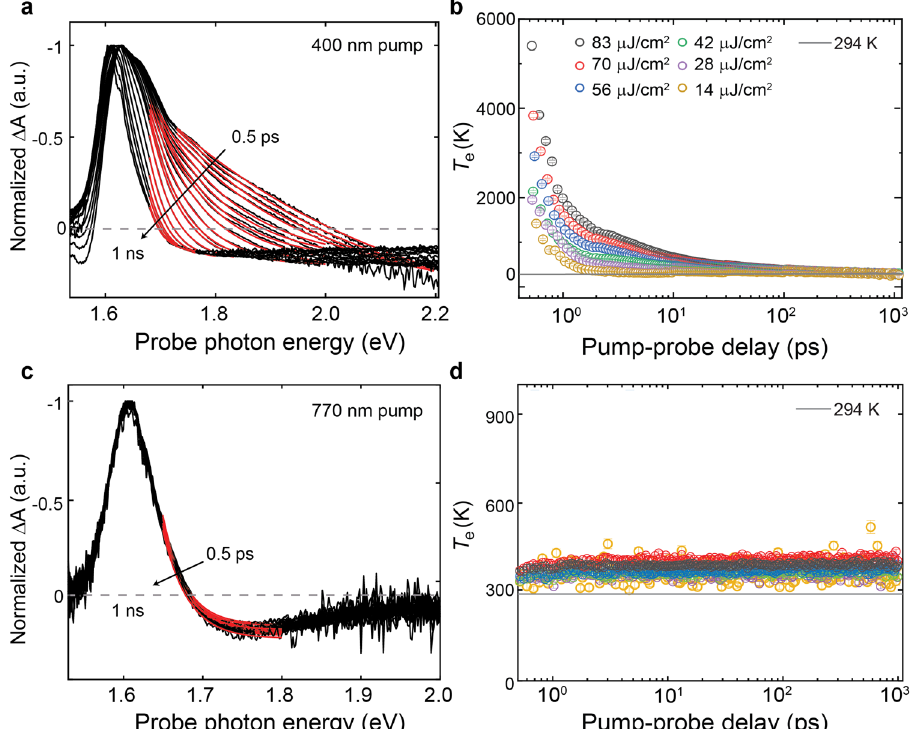
Fig. 2 Transient absorption spectra measurements. a Normalized transient absorption spectra with fl uence of ~ 83 μ J/cm 2 under 400-nm pump. Red solid lines are the Maxwell-Boltzmann fi t curves by using Eq. (4). b Extracted carrier temperatures under 400-nm at different pump fl uences. c Normalized transient absorption spectra with fl uence of ~83 μ J/cm 2 under 770-nm pump. d Extracted carrier temperatures under 770-nm pump at different pump fl uences. The horizontal line marks the temperature of 294 K. Errors of T fi dence interval, e are standard error that is determined by calculating the 95% con based on residual values and Jacobian matrix obtained from the fi ts to Eq.